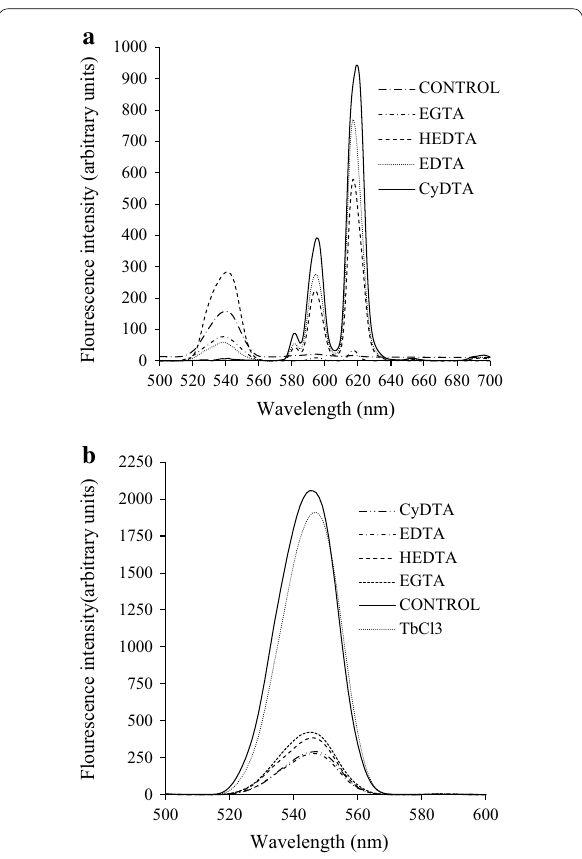
Fig. 1 Effects of different clathrates with EuCl 3 ( a ) and TbCl 3 ( b ) on DPA fluorescence intensity and emission fluorescence spectra. DPA final concentration 400 nM ( a ), and 100 nM ( b